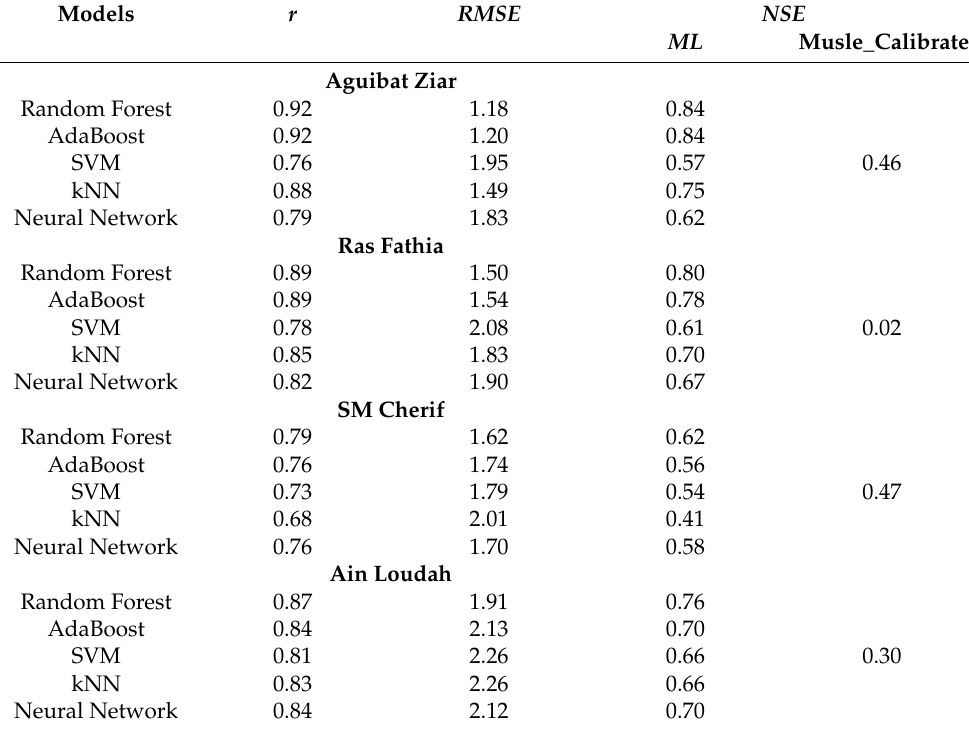
Table 5. Machine learning model performances during the training